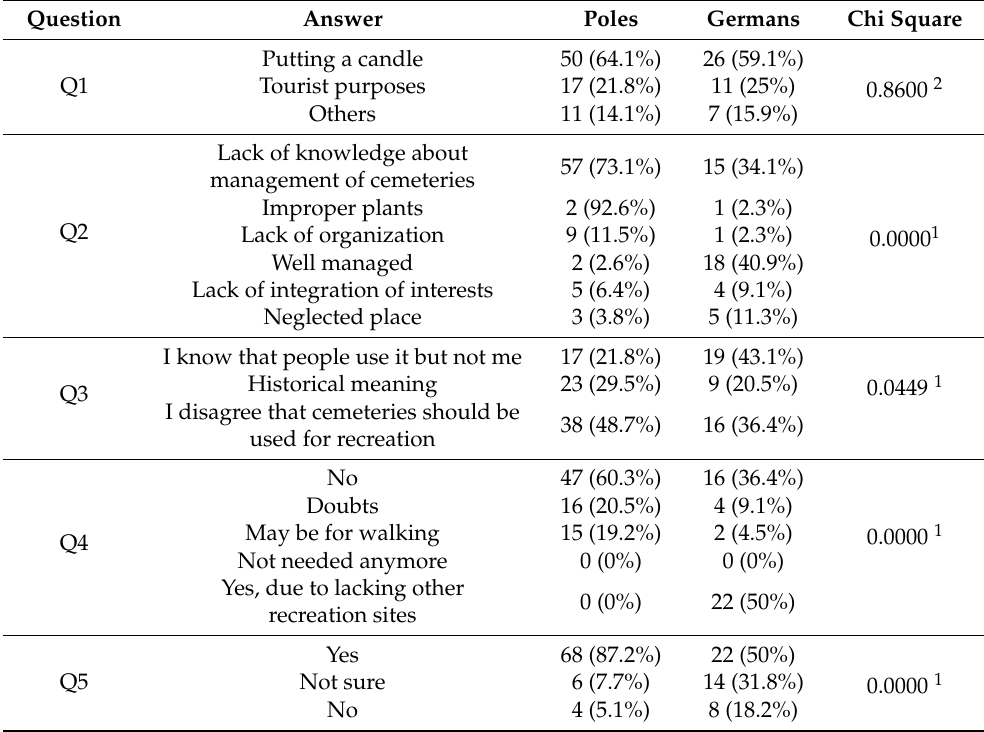
Table A1. Comparison of response rates between respondents by nationality (chi square